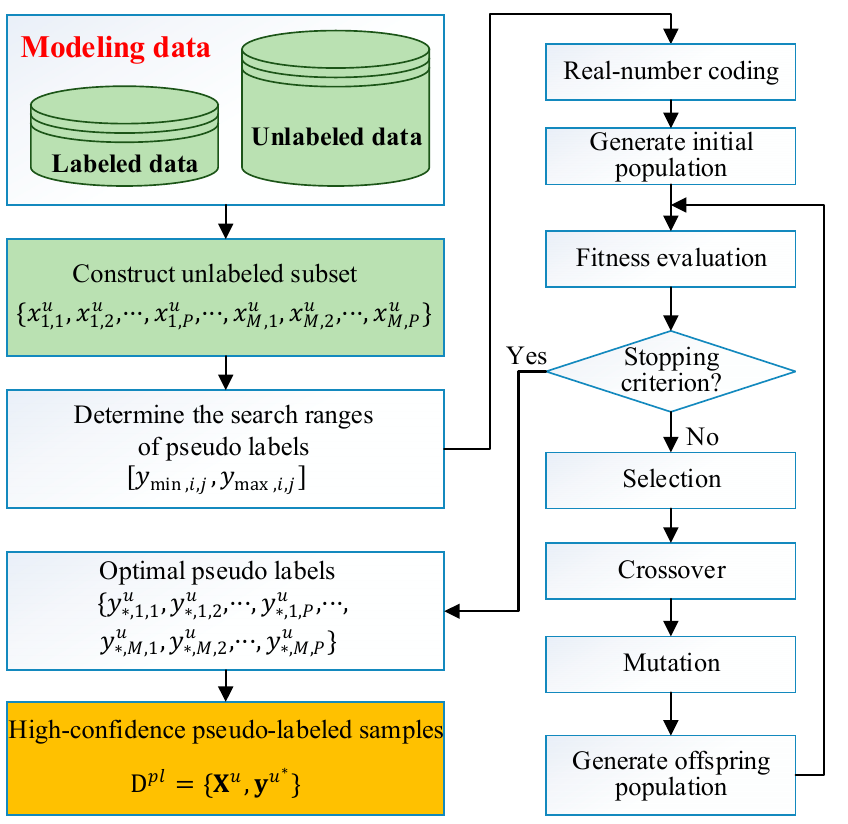
Figure 1. Schematic diagram of solving the MLPLO problem using GA.